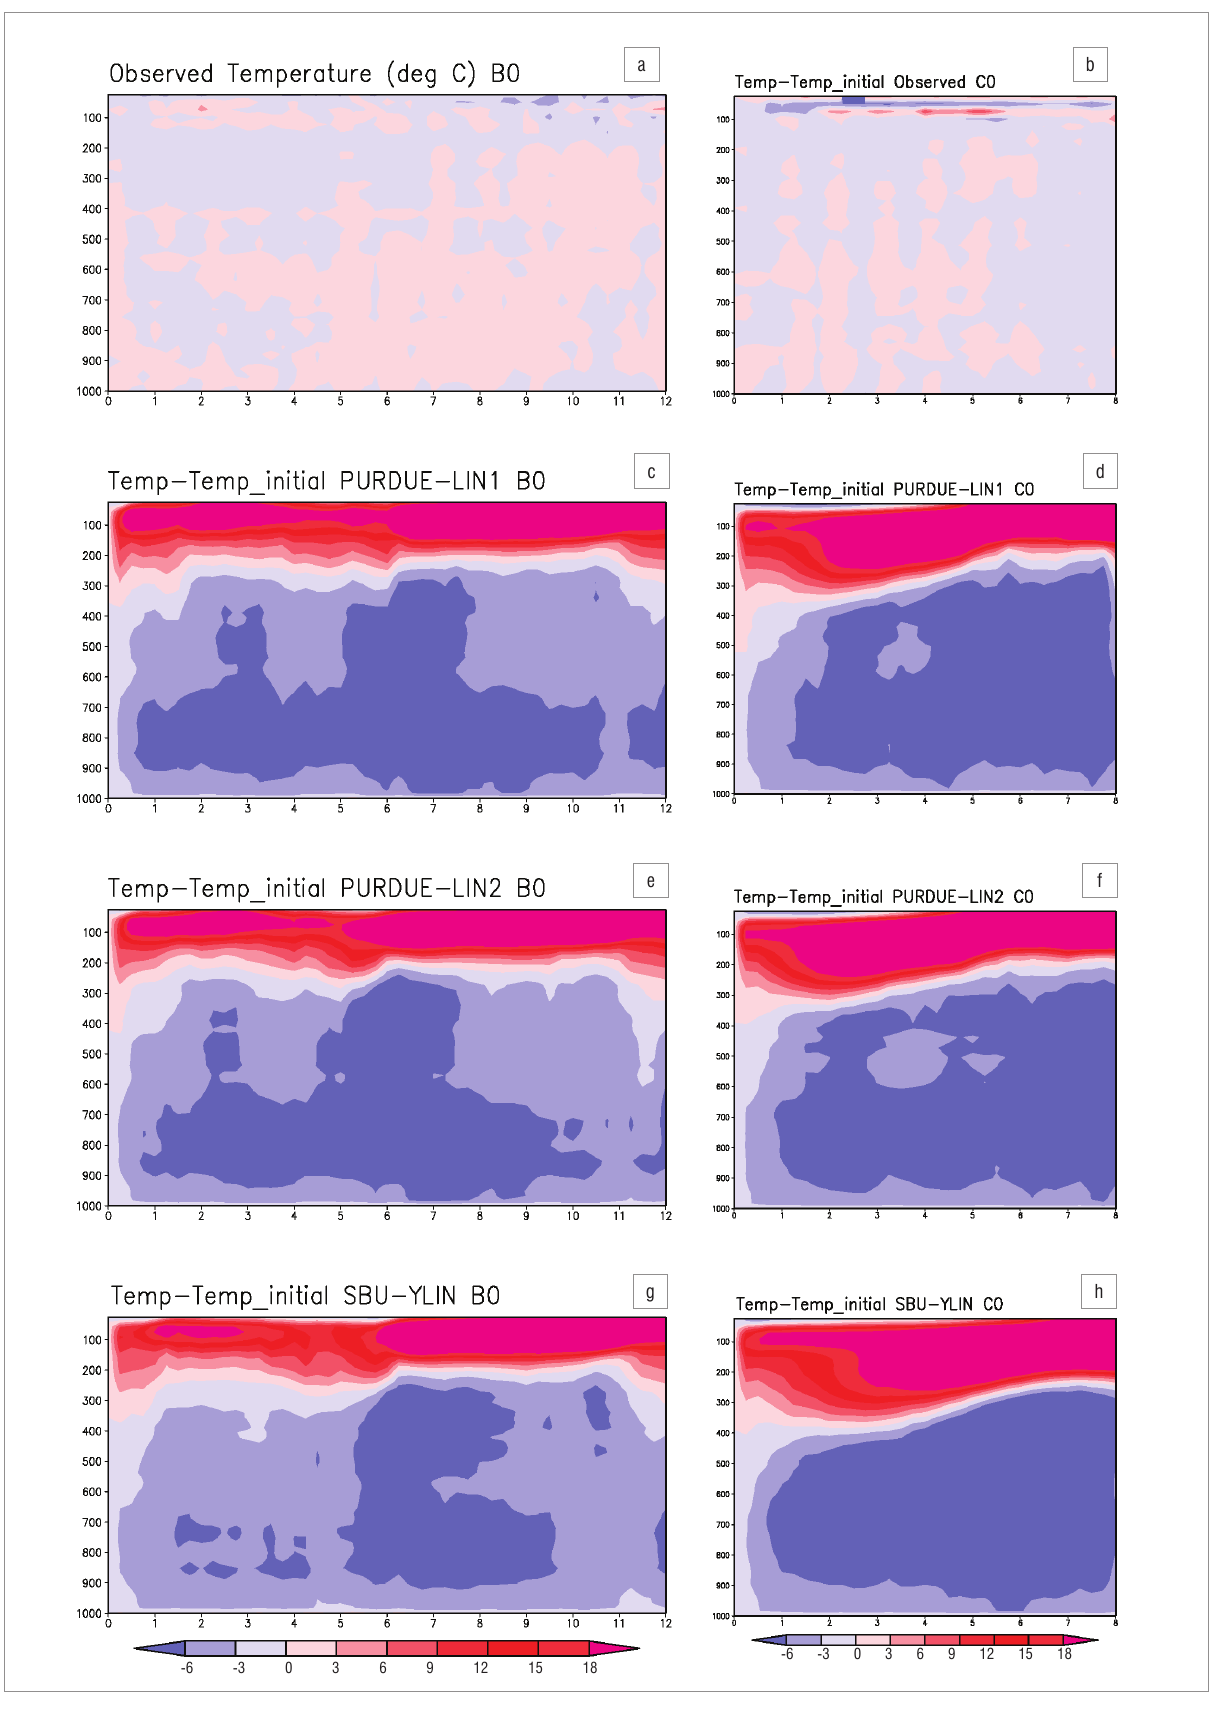
Figure 2: The temporal evolution of temperature relative to the initial conditions for (a) B0 and (b) C0 experiments. The simulated temporal temperature evolution with different microphysics schemes (c,e,g) for the B0 experiment and (d,f,h) for the C0